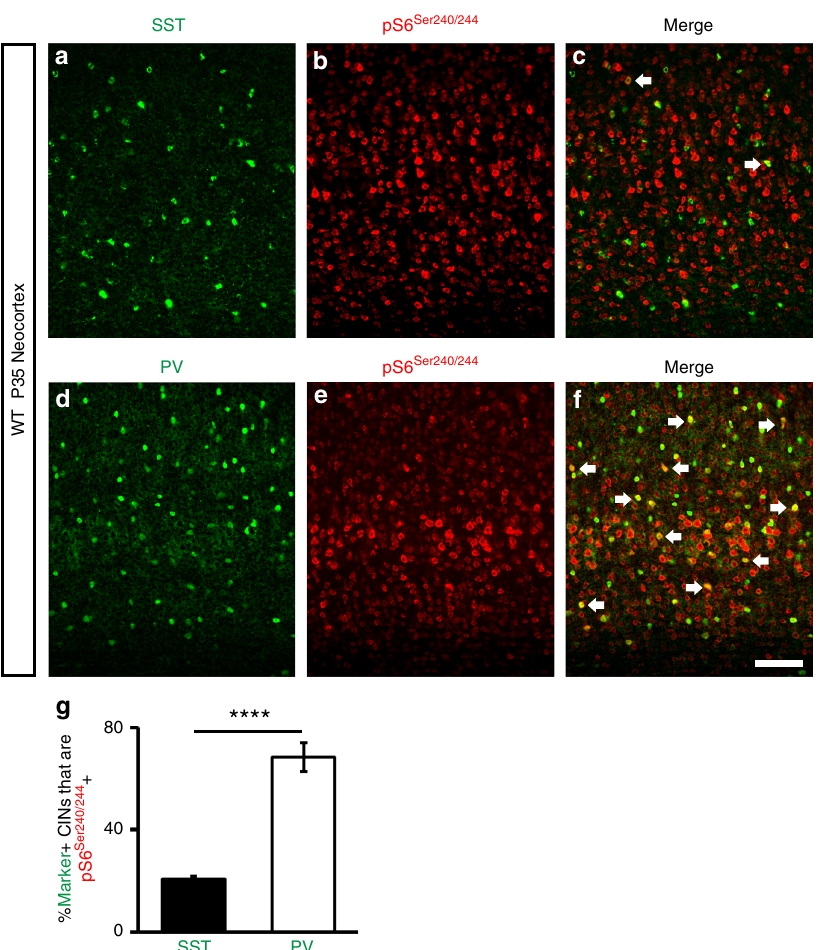
Fig. 2 The MTOR activity marker, pS6, is preferentially enriched in PV + CINs. a – c P35 immuno fl uorescent images of WT neocortices co-labeled for SST and pS6. d – f Immuno fl uorescent co-labeling of PV and pS6 from P35 WT neocortices. Arrows denote co-labeled CINs. g Quanti fi cation of the % of either SST + or PV + CINs that are pS6 + : Chi-squared test with Yate ’ s correction, **** p < 0.0001. Data are expressed as the ± SEM, n = 3 mice/marker (145 SST cells and 208 PV cells counted). Scale bar in f = 100 µ m. Source data are provided as a Source Data fi